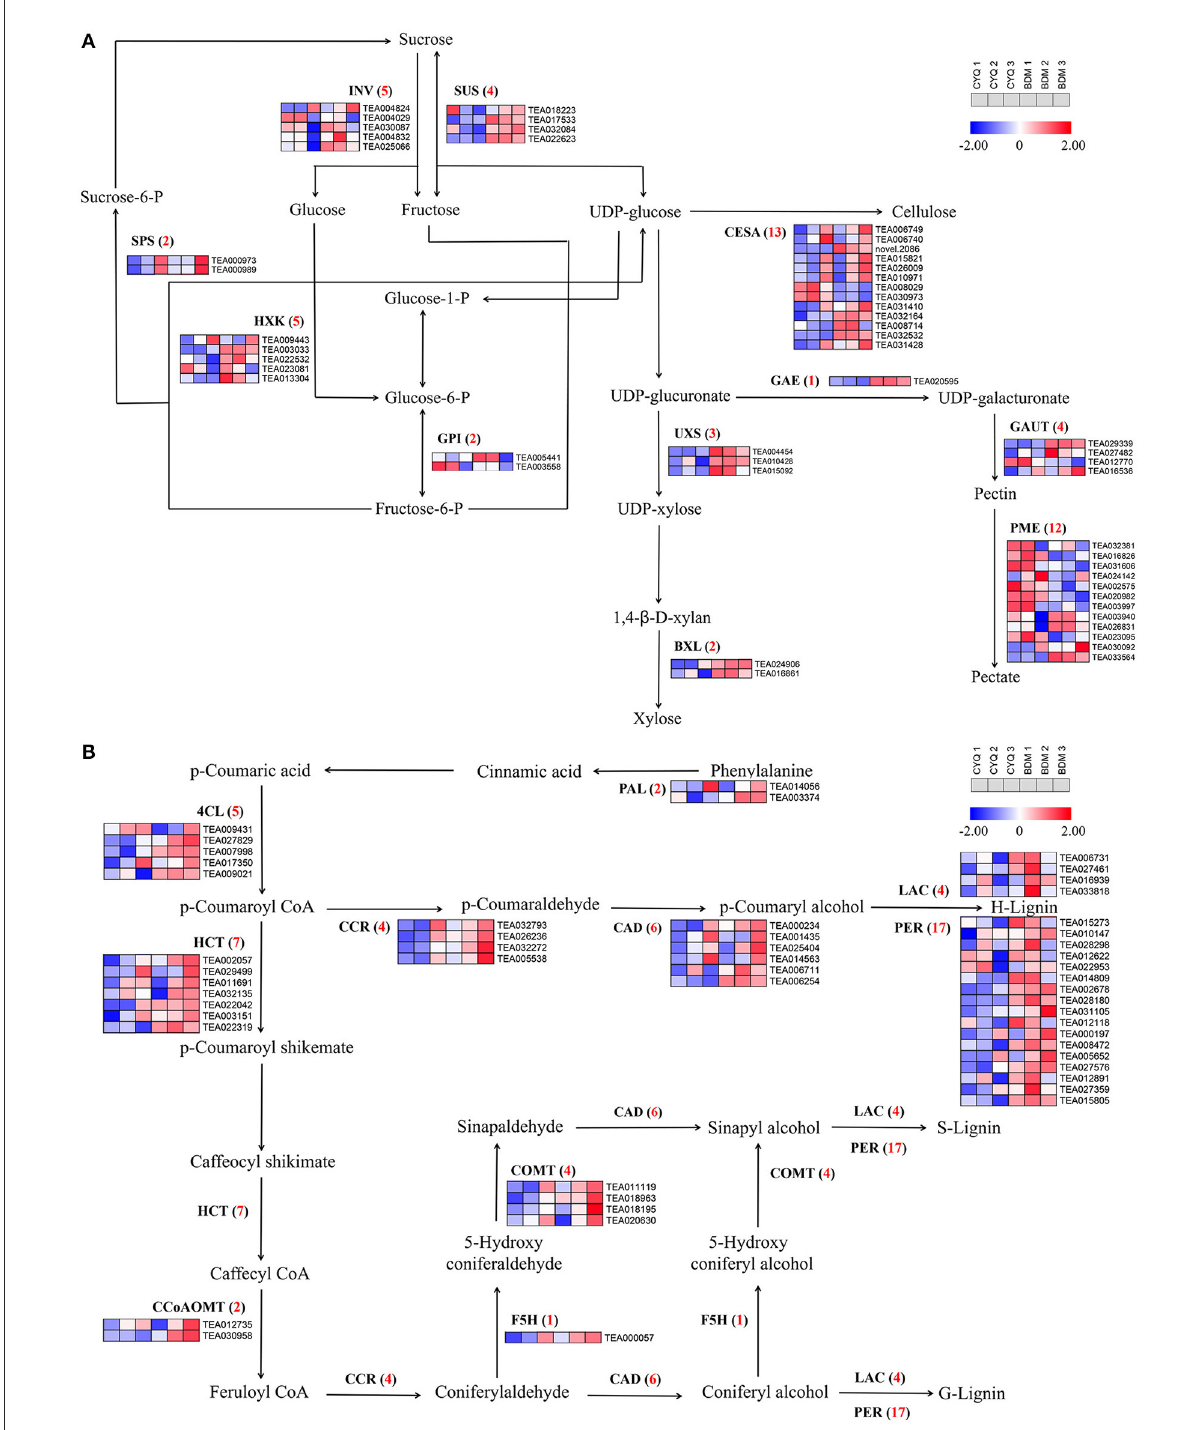
FIGURE7 The cellulose, pectin, and lignin biosynthesis pathway and related gene expressions. (A) DEGs involved in cellulose and pectin biosynthesis pathway. Numbers in parentheses following each gene name indicated the number of corresponding DEGs. The expression levels of DEGs were normalized by log 2 (FPKM). (B) DEGs involved in lignin biosynthesis pathway. Numbers in parentheses following each gene name indicated the number of corresponding DEGs. The expression levels of DEGs were normalized by log 2